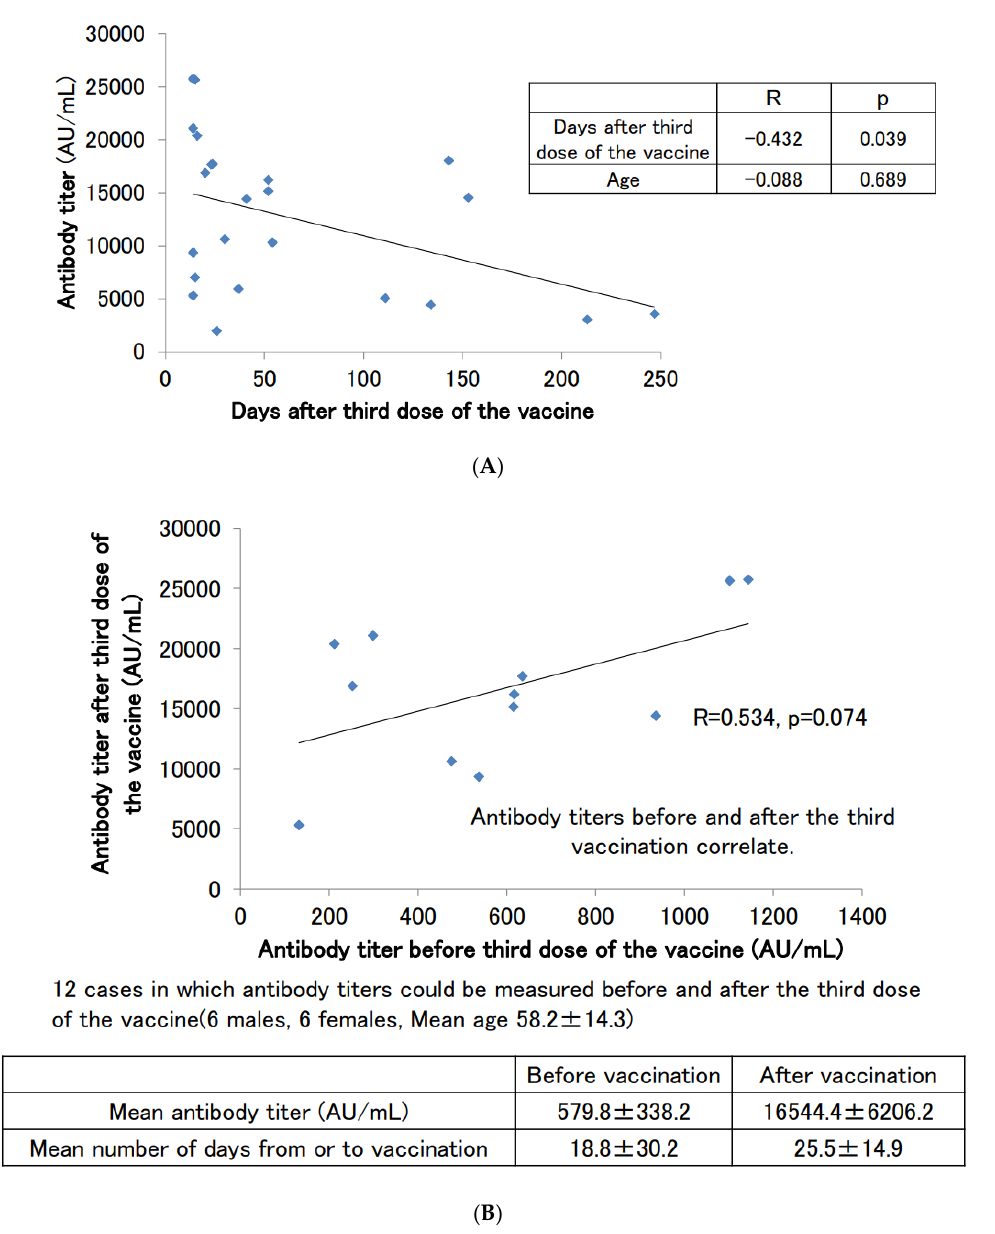
Figure 4. ( A ) SARS-CoV-2 antibody titers in participants with no history of COVID-19 infection who had antibodies measured after the third dose of the vaccine. ( B ) Correlation of SARS-CoV-2 antibody titers before and after the third dose of the